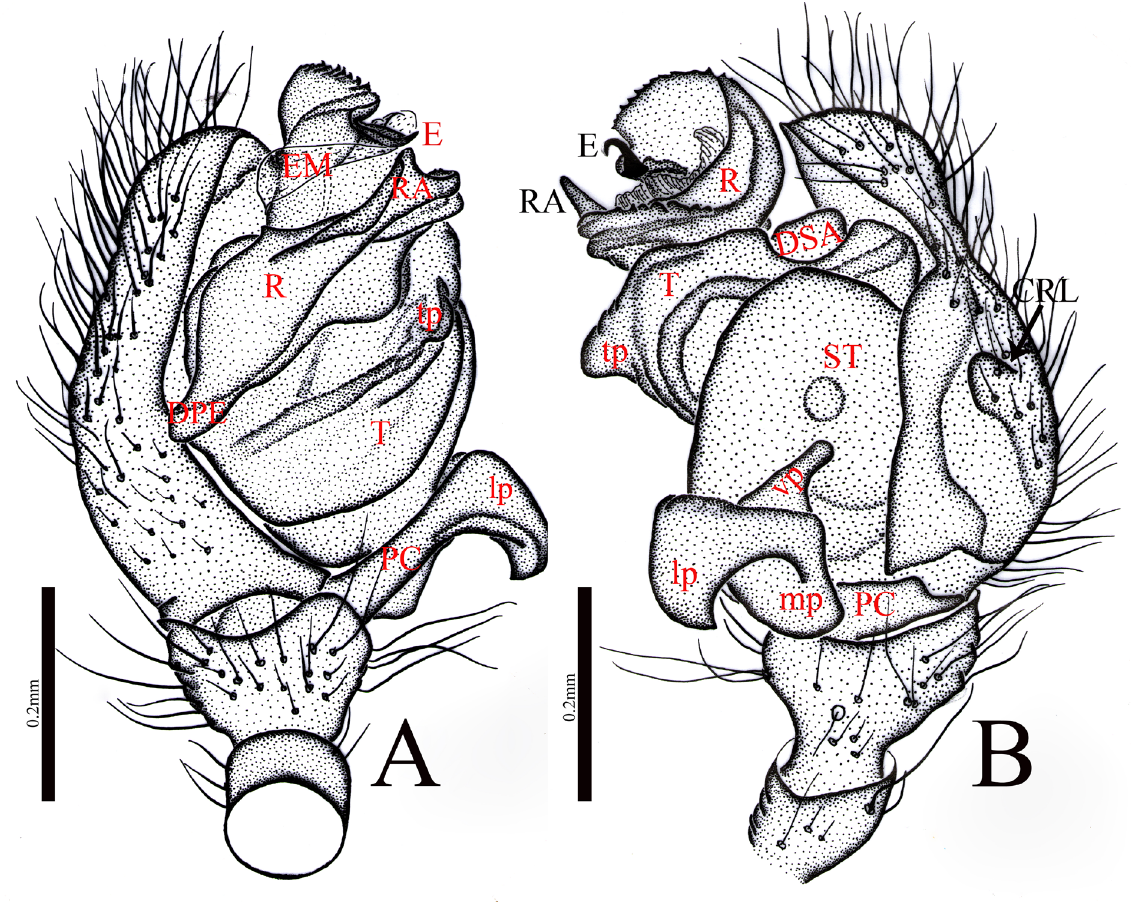
Fig. 7. Acroterius brevis gen. et sp. nov., ♂, holotype (HNU-20040501–1), palp. A . Prolateral view. B . Retrolateral